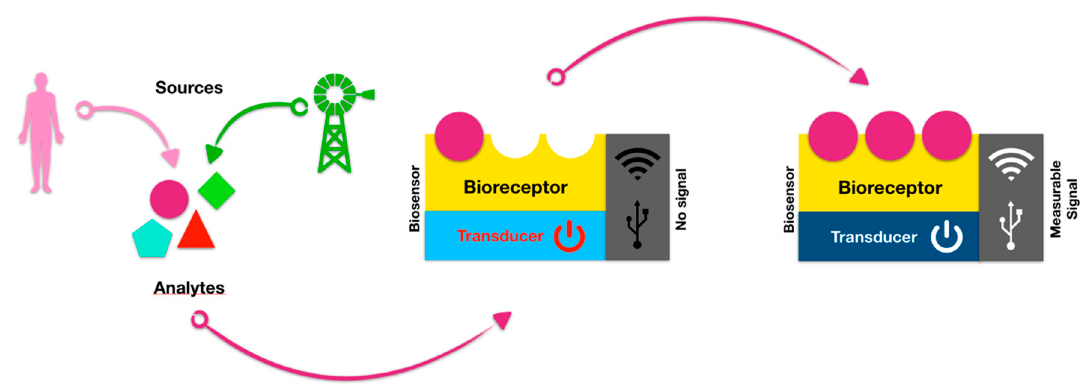
Figure 1. Scheme of a standard biosensor. The biological part is either integrated or closely associated with the physical transducer, and behaves as a recognition element, capable to detect a specific biological analyte, thus generating a measurable signal.